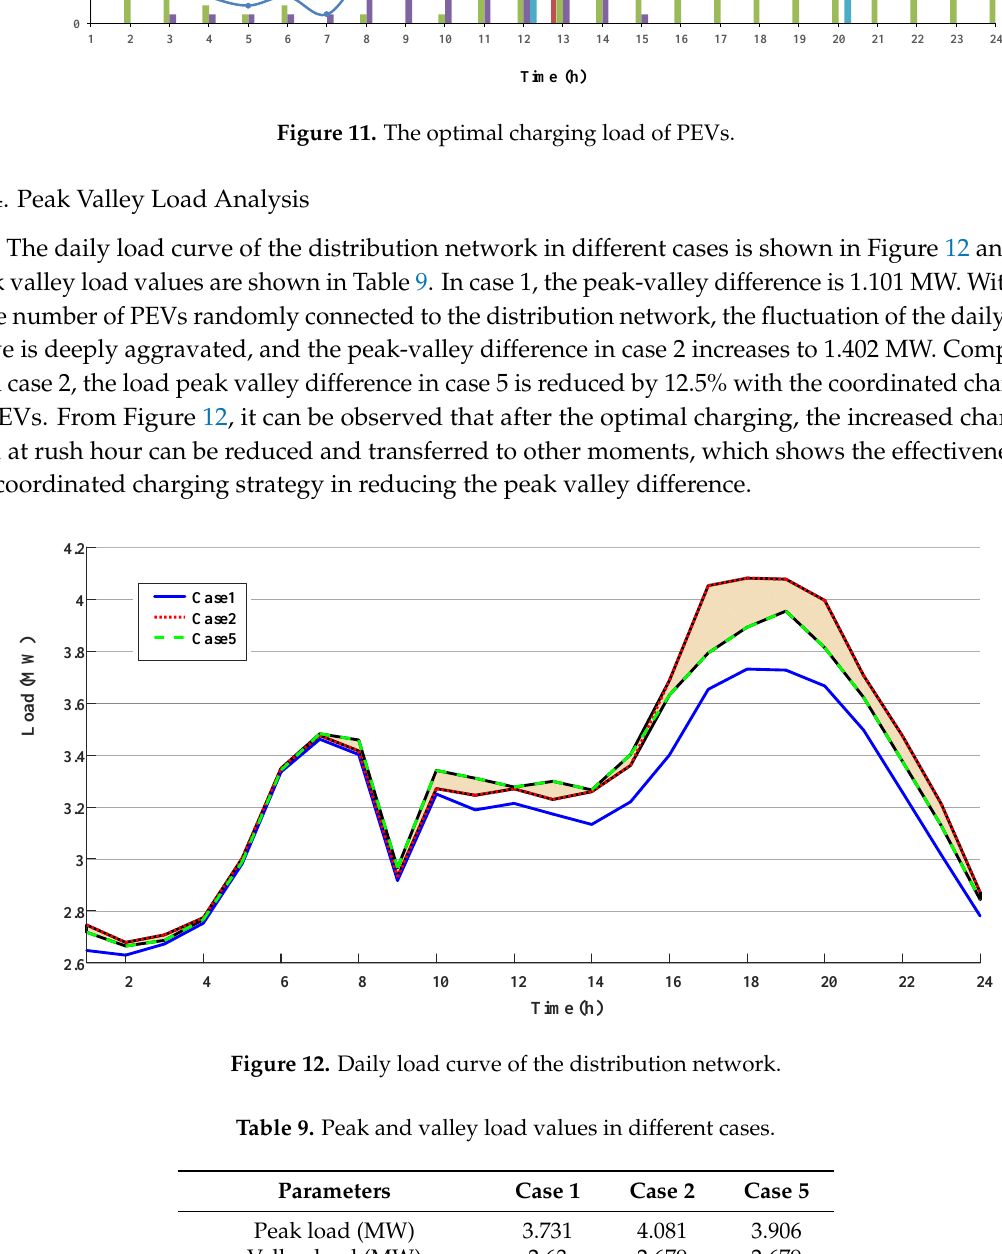
Figure 12. Daily load curve of the distribution network.